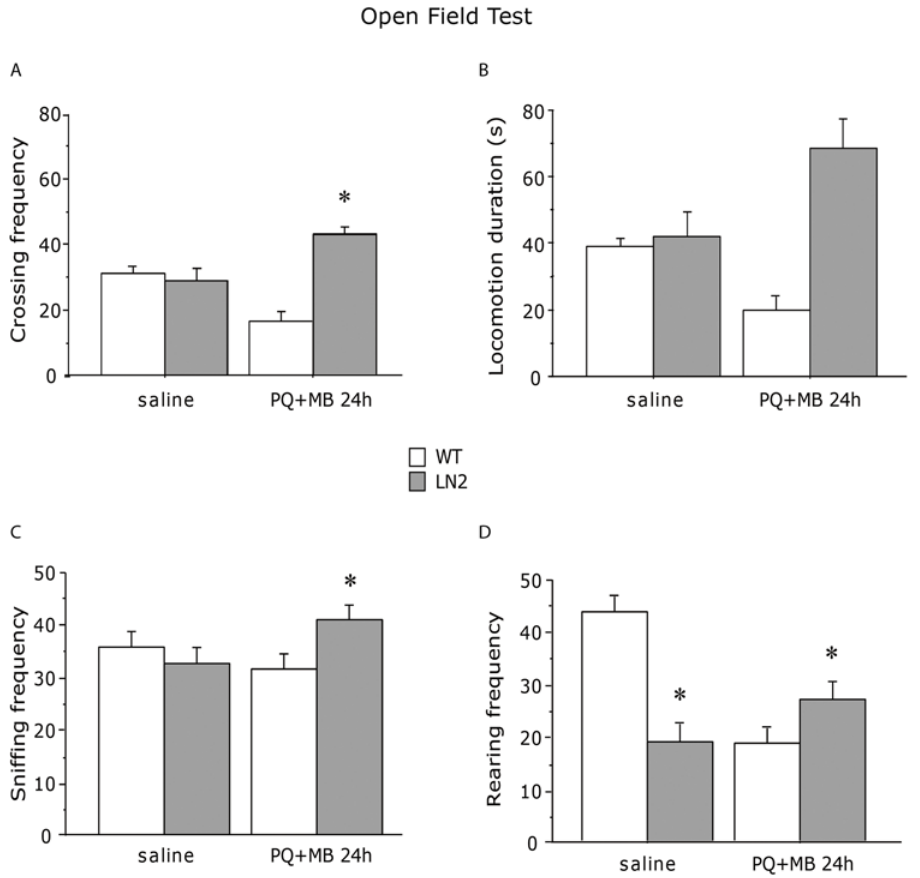
Fig 3. Assessment of spontaneous locomotor activity 24 h following administration of PQ+MB in old mice (21 month-old). After treatment Tg-mice showed increased locomotor (A, B) and exploratory activities (C, D), compared to wild type subjects of the same age. Results are presented as mean + S.E.M. * P < 0.05.